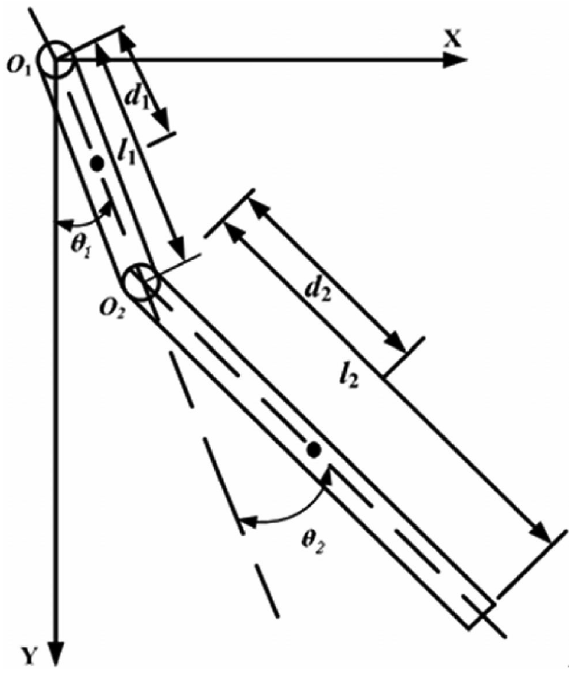
Fig. 1. Model of a two-bar